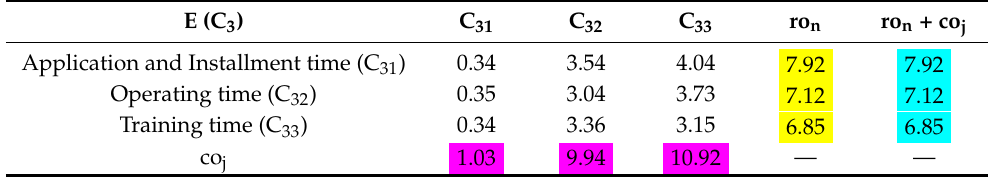
Table 18. Total direct influence matrix T between Time (C 3 ) sub-criteria.